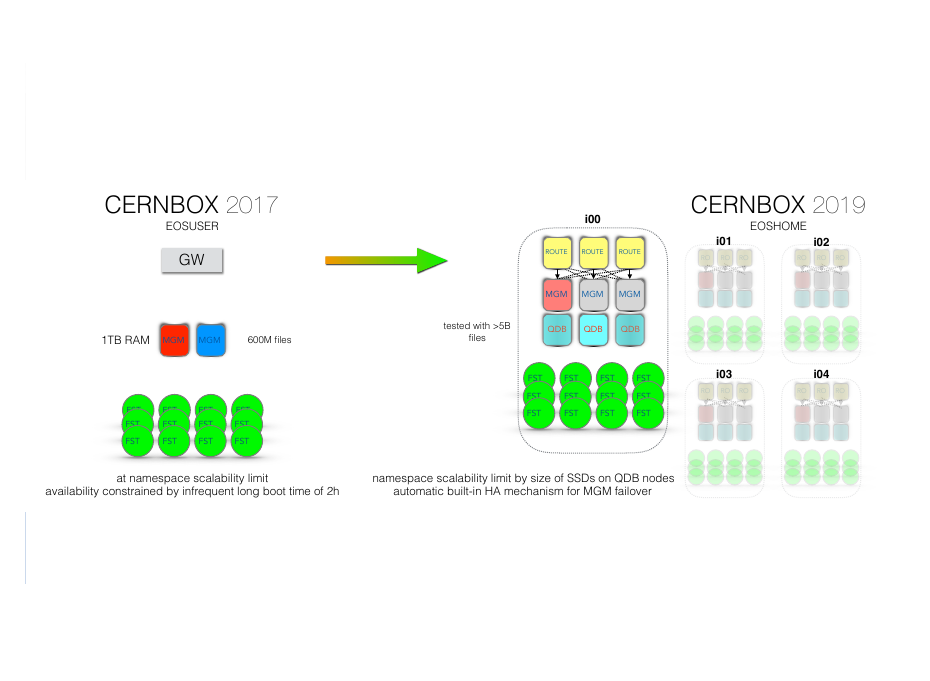
Figure 1. Namespace Architecture